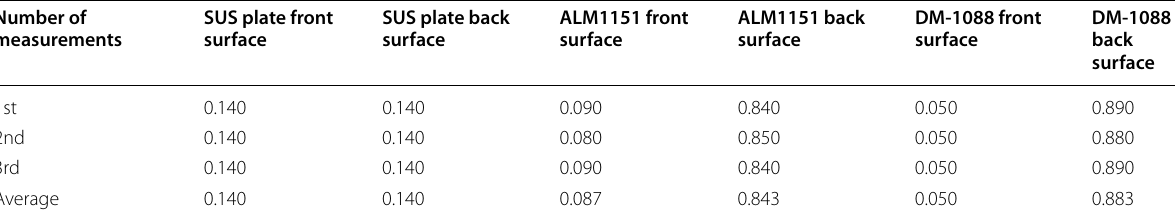
Fig. 7 Image of the developed radiant heat-resistant exterior cover and cross-sectional schematic diagram